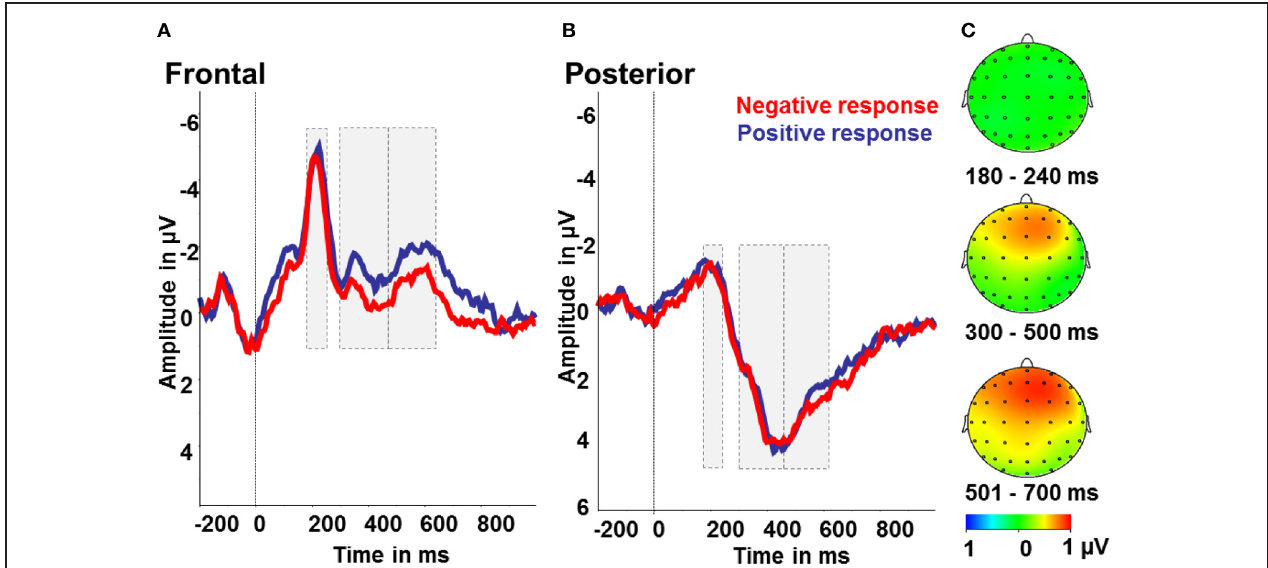
FIGURE 5 | Interpretation bias effect: ERP amplitudes for positive (blue) and negative responses (red) to the intermediate tones. (A) Frontal region of interest. (B) Posterior region of interest. (C) Activity difference of